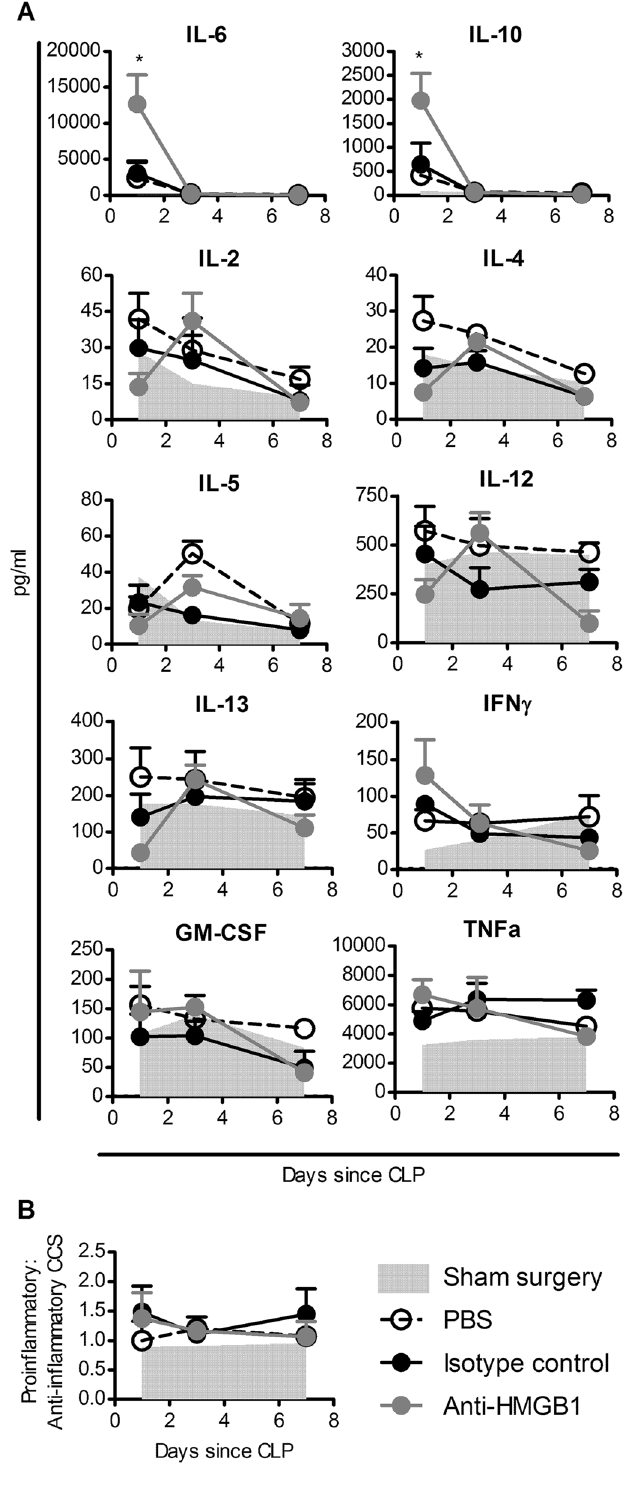
Figure 5. Ovine anti-HMGB1 pAb-treated mice display cytokine profiles associated with improved clinical outcomes in the early phase of CLP-induced sepsis. Blood samples from mice (n = 3–5) subjected to sham- surgery (pale grey area) or CLP-induced sepsis and treated with PBS (unfilled symbols), control pAb (25 mg/ kg; black symbols) or anti-HMGB1 pAb (25 mg/kg; grey symbols) were analysed for cytokine content using a multiplex platform. Mean + SEM of individual cytokine measurements are depicted. ( A ). Proinflammatory (IL- 2, IL-5, IL-6, IL-12, IFN γ , GM-CSF and TNF α ) to anti-inflammatory (IL-4, IL-10 & IL-13) CCS were calculated for each sample, mean + SEM group CCS normalised to median values are depicted in ( B ). Levels of cytokines were compared using two-tailed T-tests, with significance denoted as thus: * P <